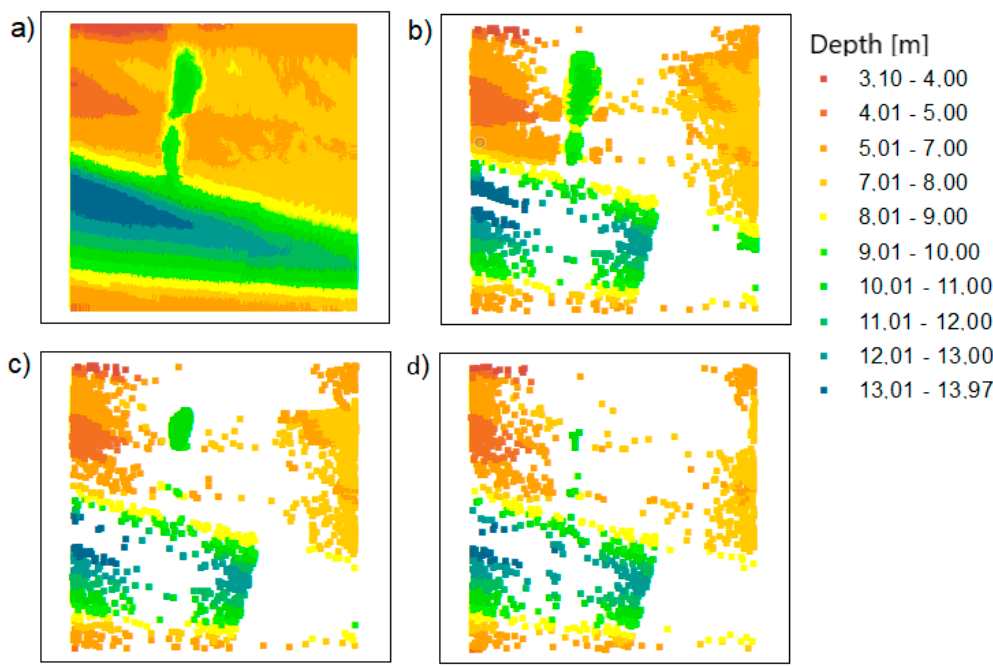
Figure 7. The points based on the Inski canal area: ( a ) raw data; ( b ) dataset reduced with the OptD method for setting no. 1; ( c ) dataset reduced with the OptD method for setting no. 2; ( d ) dataset